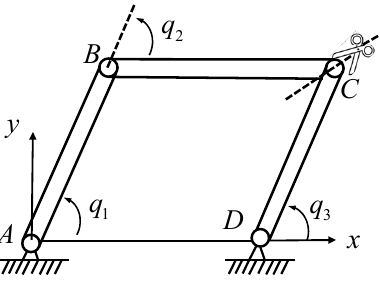
Figure 3. Multibody model of a planar four bar mechanism.